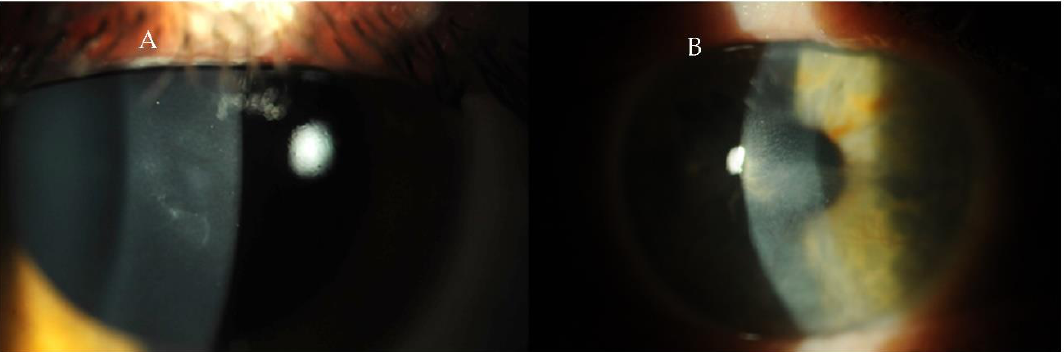
Figure 3. ( A , B ) Photographs of the anterior segment of the eye with corneal keratopathy causing irregular astigmatism in the course of SLE.